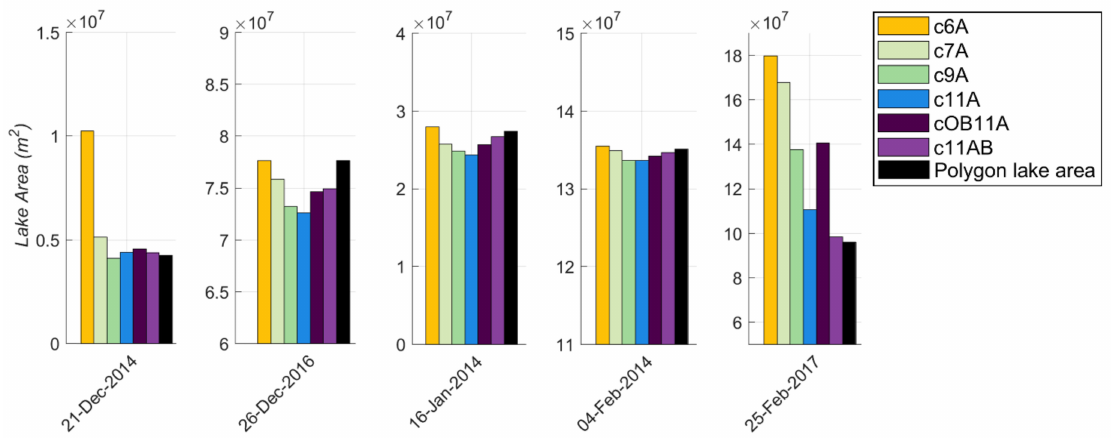
Figure 5. For the five scenes with manual high-confidence lake / non-lake polygons, we compare the sum of the lake polygon areas with classified lake areas results across both lake and non-lake polygon areas.